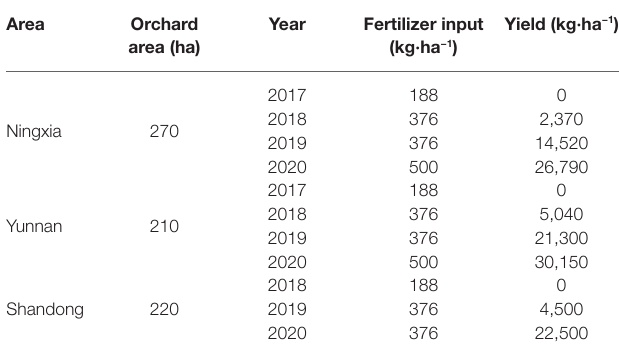
TABLE 7 | BCRF application amount and peach fruit yield in three provinces.